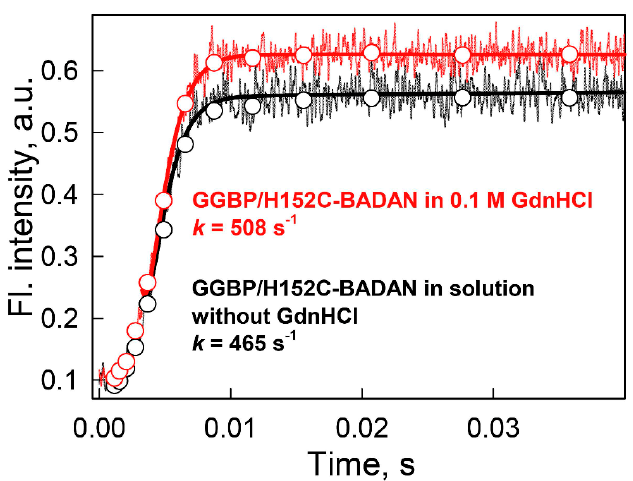
Figure 6. The kinetics of glucose binding to GGBP/H152C-BADAN in solutions without denaturants (black curve) and in the presence of 0.1 MGdnHCl (red curve). The solid lines represent best fit of data by exponential model. The circles represent the data array after logarithmic transformation of experimental data. The excitation wavelength was 387 nm. Glucose concentration was 0.5 mM.